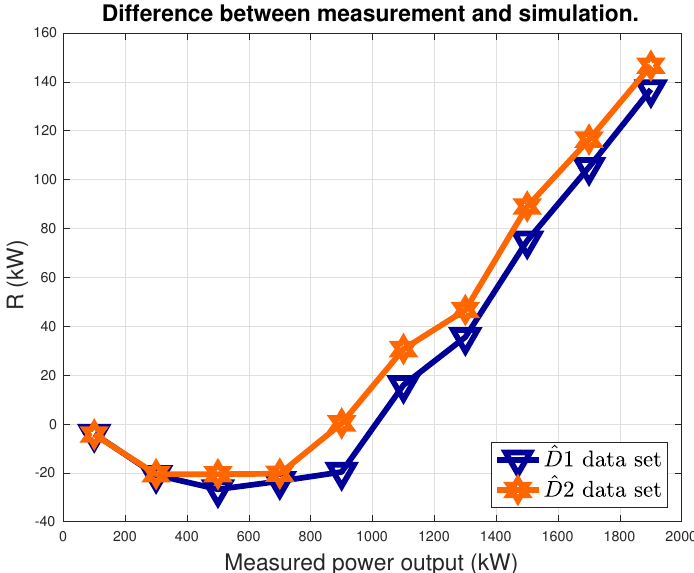
Figure 7. The average difference R between power measurement y and estimation ˆ y (Equation 8). Data sets: D1 and D2. Sample run of the model.